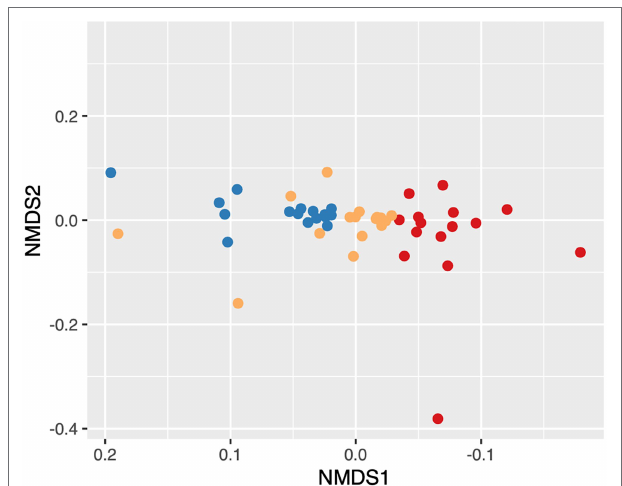
FIGURE 5 | NMDS of Bray–Curtis dissimilarity distances of community function. Functions based on MEGAN-LR evolutionary genealogy of genes: Non-supervised Orthologous Groups (EGGNOG) Clusters of Orthologous Group (COG) classifications. Points colored by the level of FPES soil disturbance with blue = undisturbed (UD; n = 16), gold = semi disturbed (SD; n = 15), and red = most disturbed (MD; n = 16).